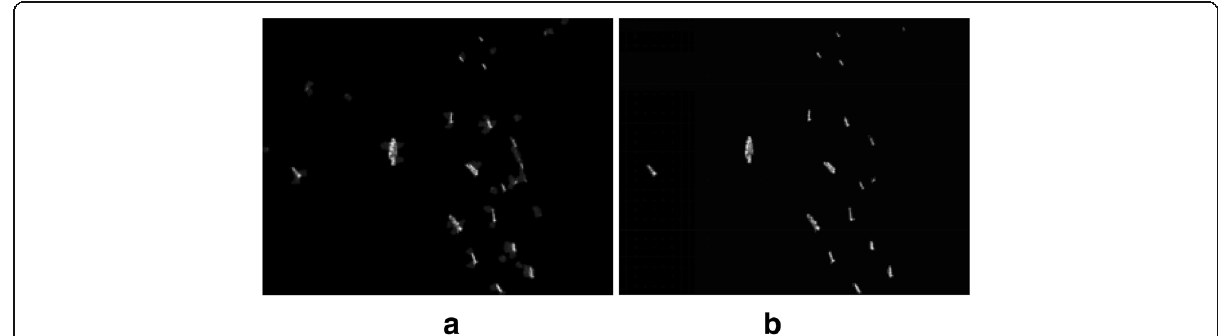
Fig. 6 The detection result based on information theory. a The candidate superpixel patches. b The weighted entropy filtering result